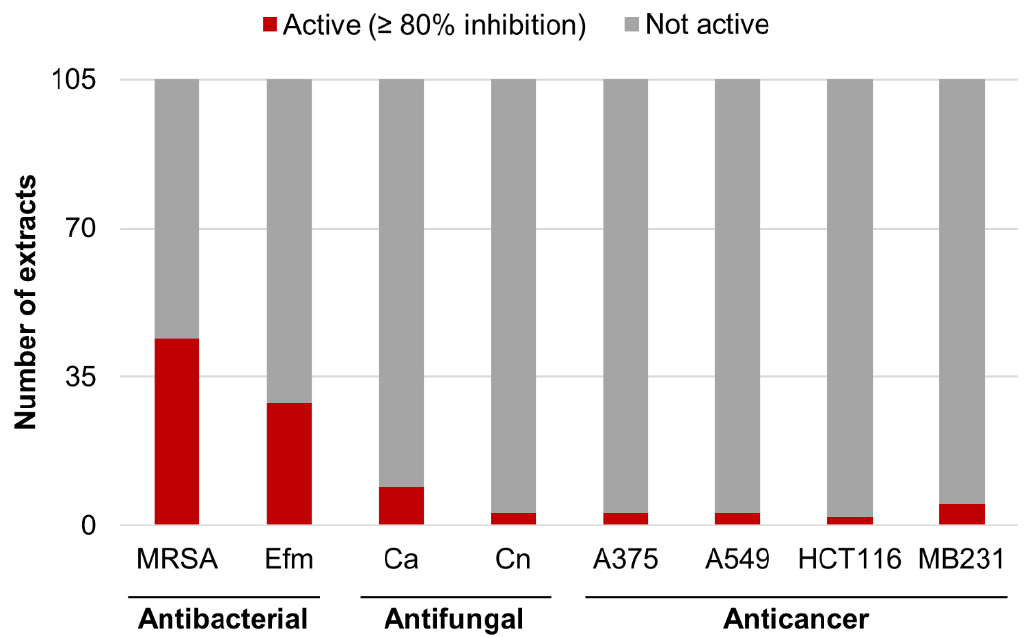
Figure 4. Bioactivities of microbial extracts ( n = 105). Number of active extracts ( ≥ 80% inhibition at 100 µg/mL test concentration) in the categories antibacterial (MRSA: Methicillin-resistant Staphylococcus aureus , Efm: Enterococcus faecium ), antifungal (Ca: Candida albicans , Cn: Cryptococcus neoformans ) or anticancer activity (A375: Malignant melanoma cell line, A549: Lung carcinoma cell line, HCT116: Colon cancer cell line, MB231: Human breast cancer cell line).